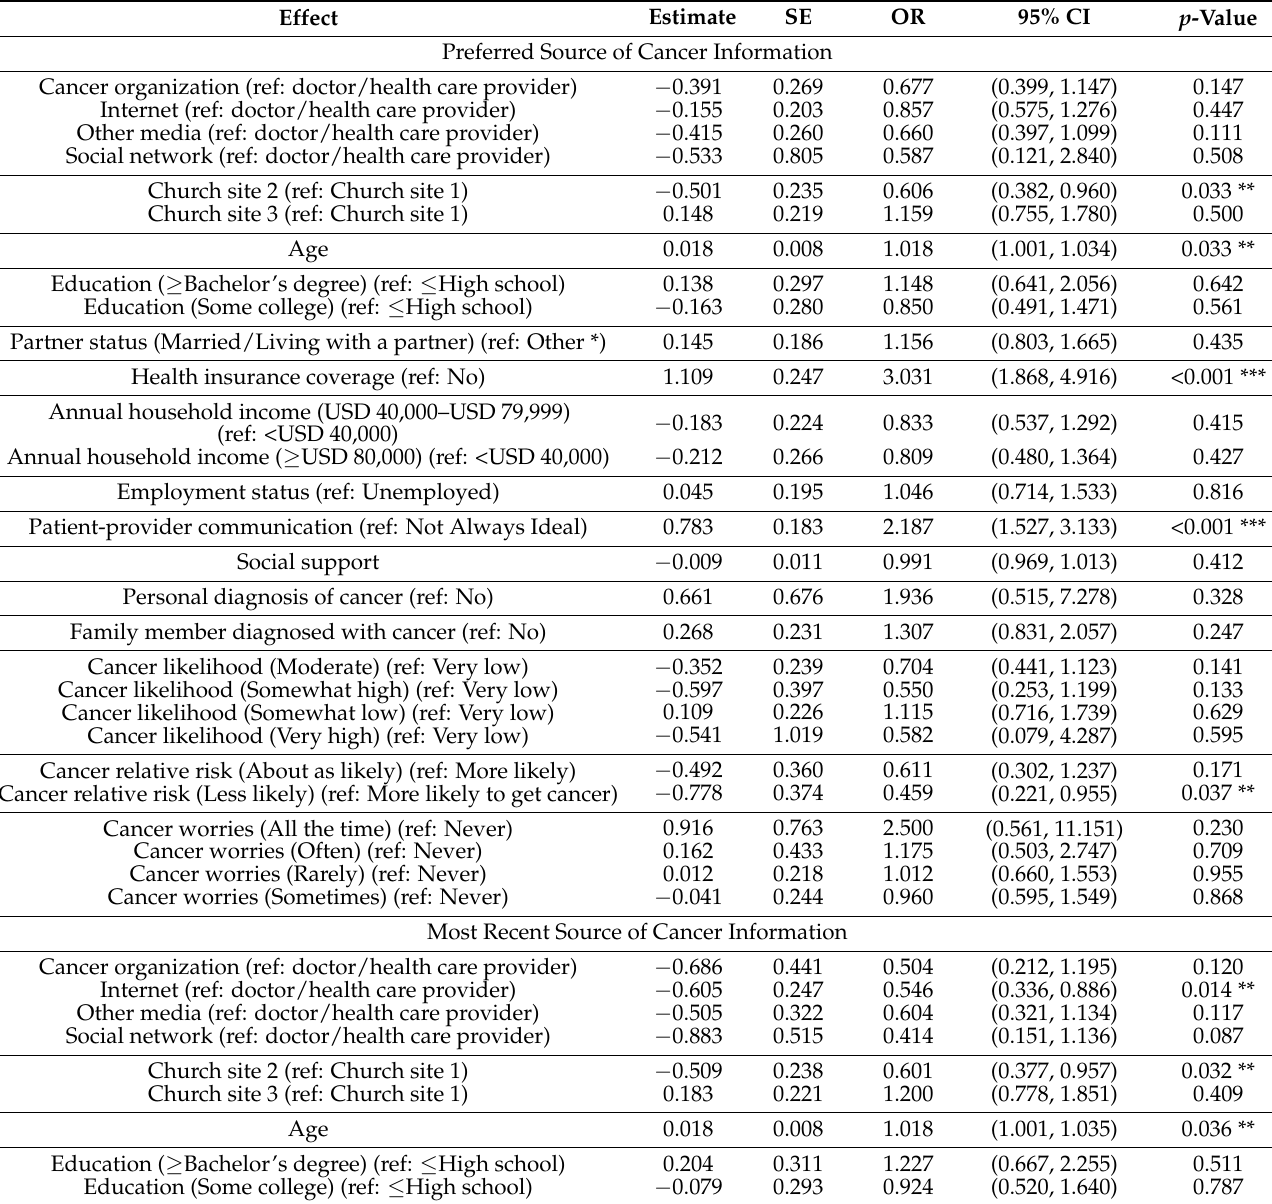
Table 2. Logistic Regression Analyses Examining Associations Between Preferred and Most Recent Source of Cancer Information, Respectively, and Having Received a Mammography in the Last Year (N = 832 Black, church-going